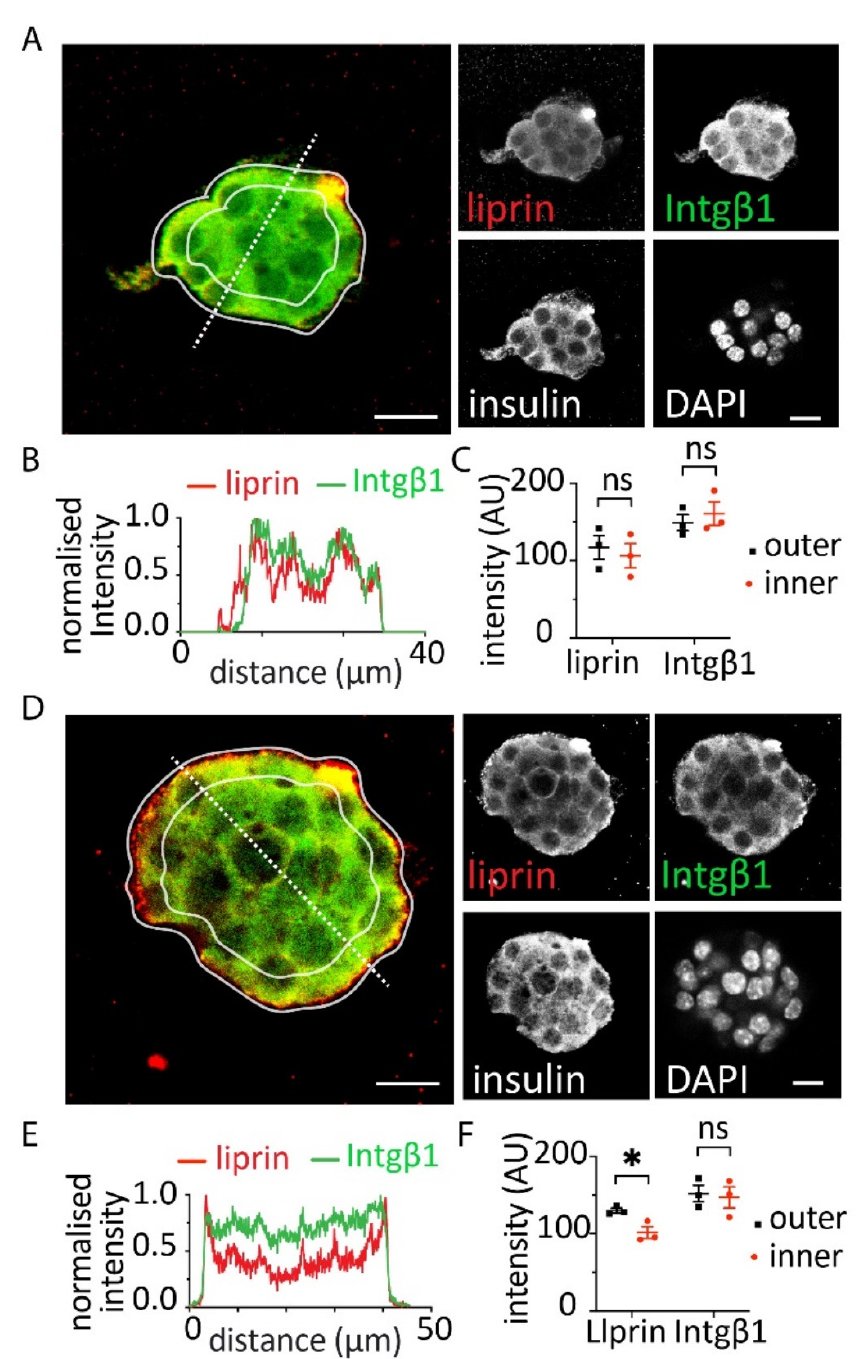
Figure 3. Immunostaining showed that cells within the spheroids reorganised in response to the RGD domain. Immunostaining of spheroids embedded in ( A – C ) alginate showed evidence for integrin β 1 and liprin throughout the cell cytosol. This was observed in the images ( A ), line scans of fluorescence intensity drawn through the spheroids ( B ) and comparison of fluorescence intensity in the inner vs. outer areas of the cluster ( C ). ( D – F ) In contrast, spheroids embedded in alginate + RGD showed evidence of enrichment in liprin on the outer surface of the outer cells, although no enrichment of integrin β 1 was observed. This was observed in the images ( D ), line scans of fluorescence intensity drawn through the spheroids ( E ) and comparison of fluorescence intensity in the inner vs. outer areas of the cluster ( F ). Counterstaining with insulin identified the cells as β cells. Scale bars 5 µm (* Student t test p < 0.05).